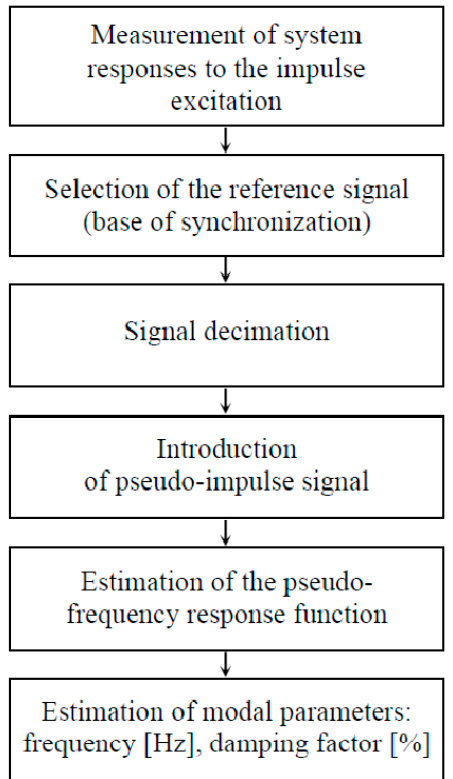
Figure 4. Computational steps of the proposed signal processing